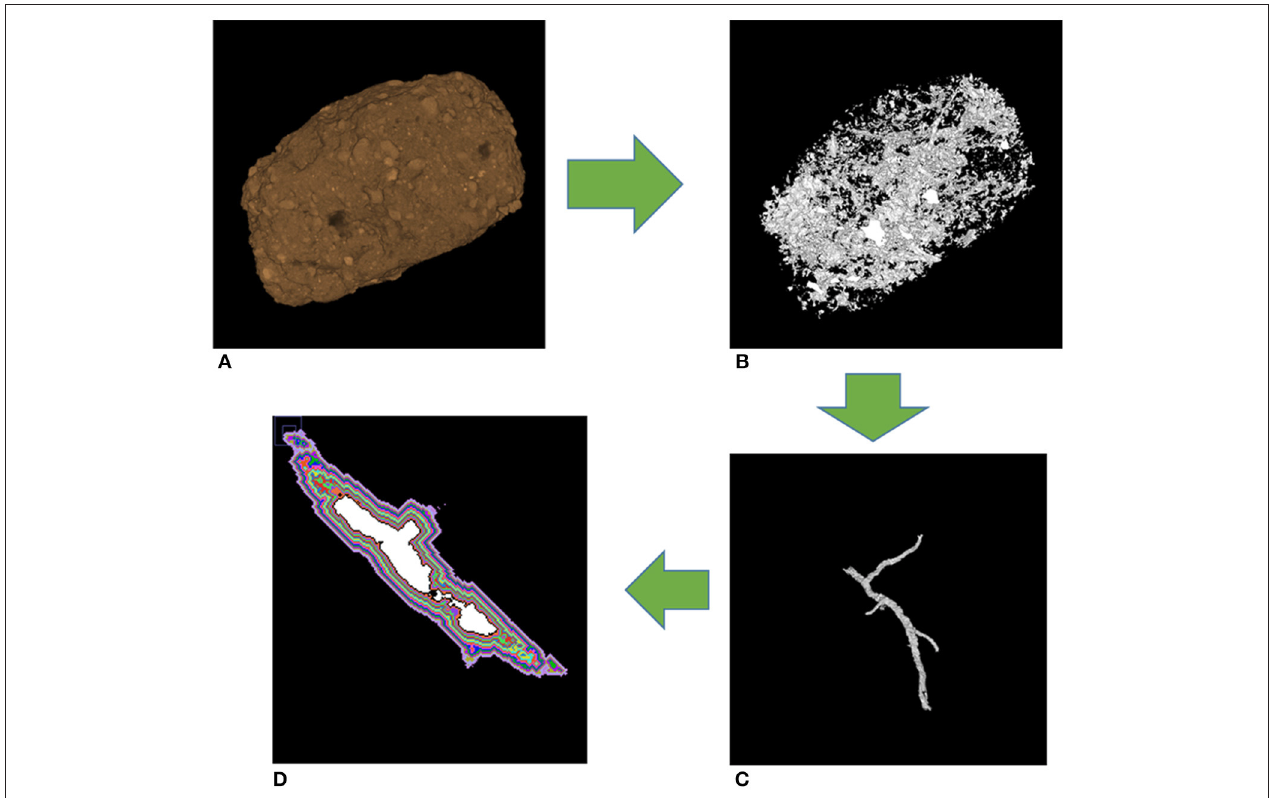
FIGURE 4 | Workflow for grayscale gradients. The whole aggregate (A) has all pores identified (B) . Individual pores are then identified (C) . Layers are collected for analyses of grayscale gradients (D) . Each color represents a different layer, while the white in the middle is the actual pore, and the black layer adjacent to white accounts for partial volume effects.